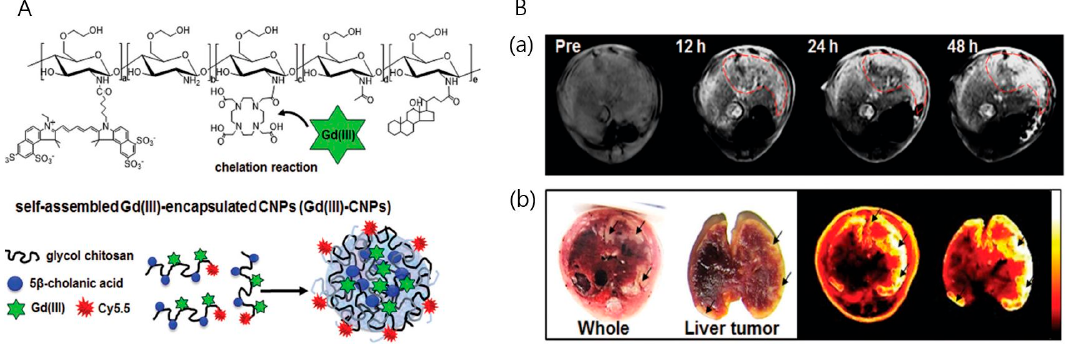
Figure 5. ( A ) Chemical structures of Cy5.5-labeled and DOTA-conjugated glycol chitosan-5 β -cholanic acid nanoparticles; ( B ) T 1 -weighted MR and optical images of liver tumor-bearing mice after injection of Cy5.5-labeled Gd(III)-chitosan nanoparticles: ( a ) axial view of liver tumor-bearing mice pre-injection and 12, 24 and 48 h post-injection (red dots mark the tumor area, demonstrating positive contrast effects); ( b ) bright field and NIRF liver cancer images indicated by black arrows (Adapted with permission from [49]. Copyright 2016 Royal Society of Chemistry).